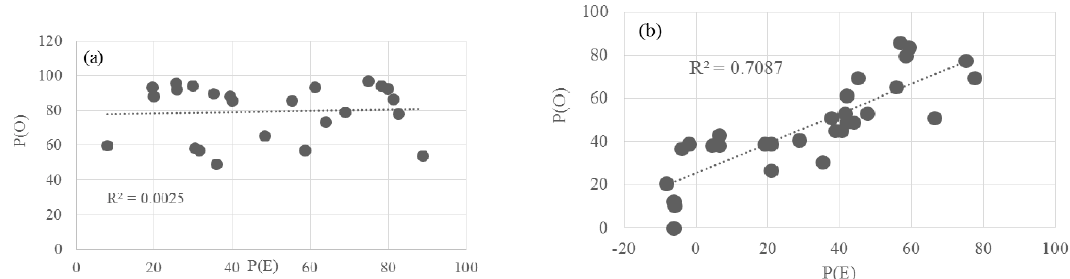
Figure 3. Correlations between theoretically expected and observed activities of ( a ) bacterial bioluminescence (24 combinations) and ( b ) seed germination (30 combinations) in the presence of binary mixtures of various NPs.